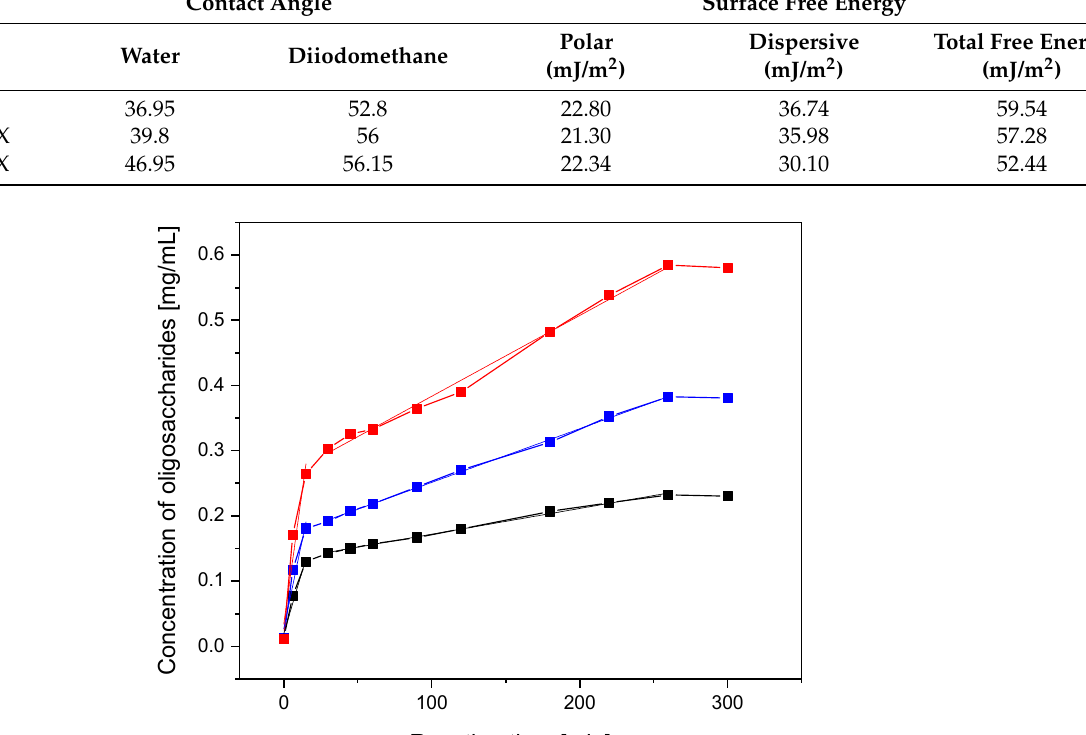
Table 2. The wettability and surface free energy of studied foil samples: ALG, ALG/Au/GOX and ALG/Ag/GOX. Sample